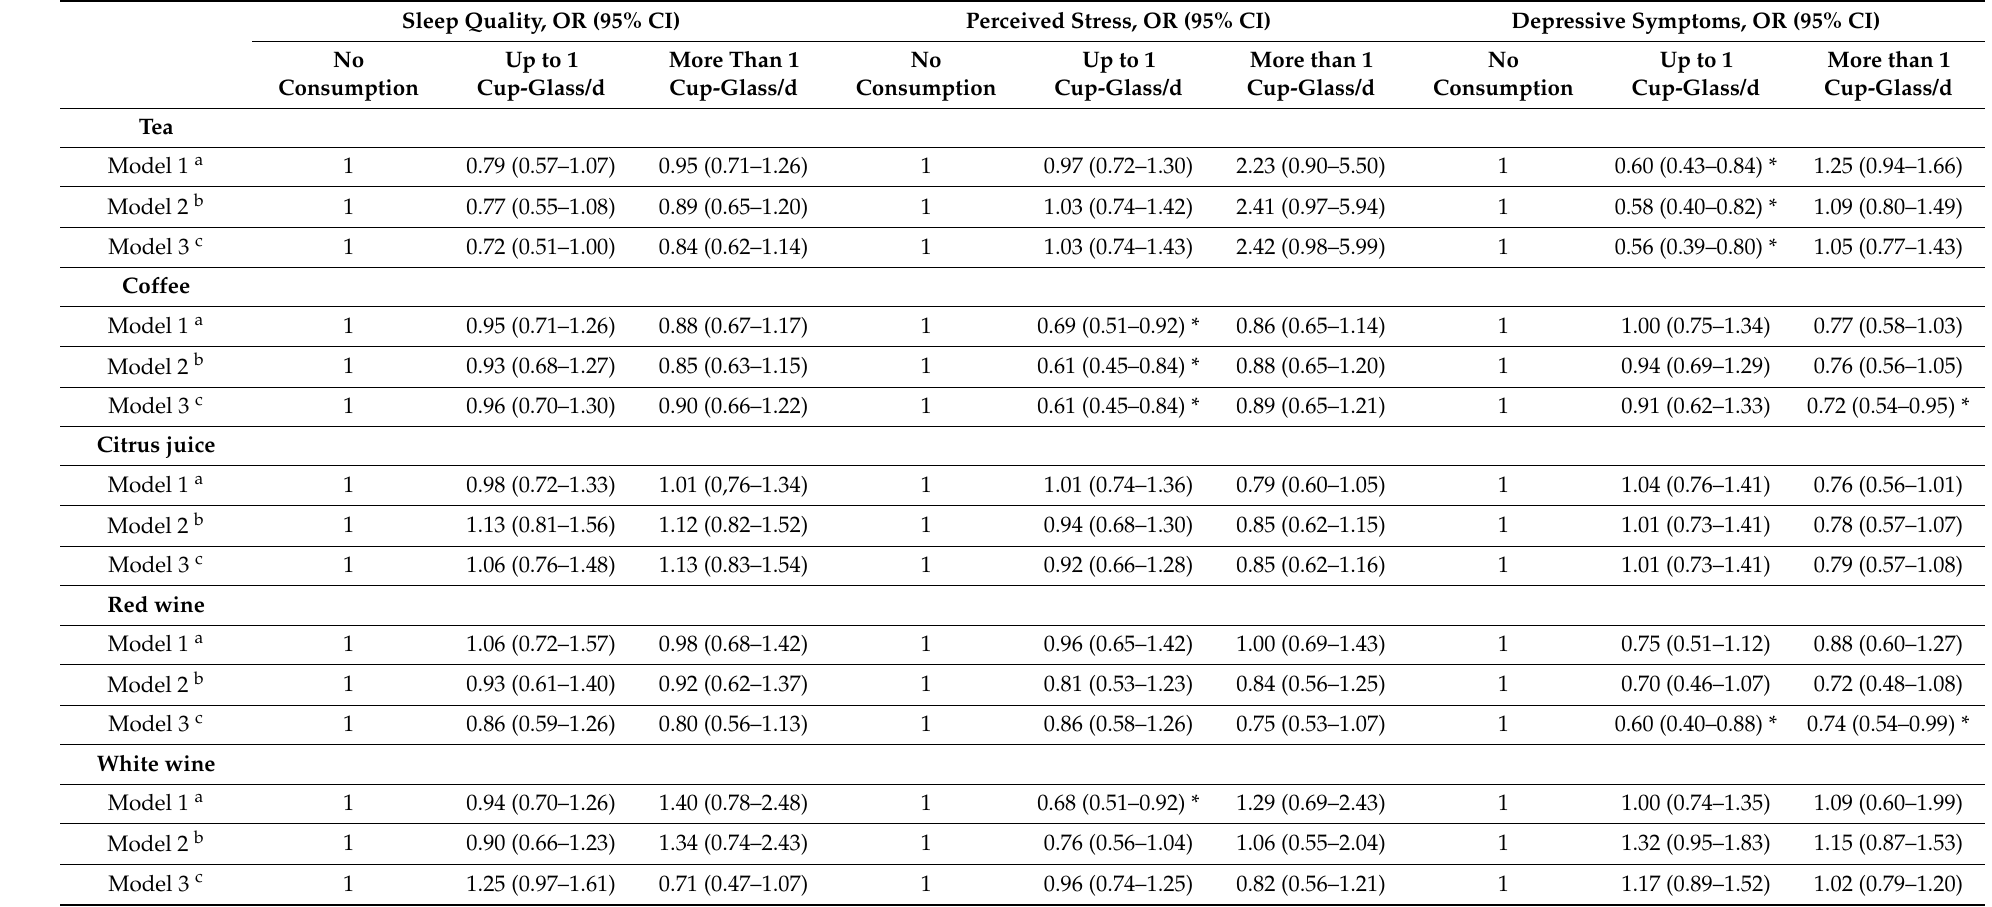
Table 4. Association between polyphenol-rich beverages consumption and mental health outcomes in the study